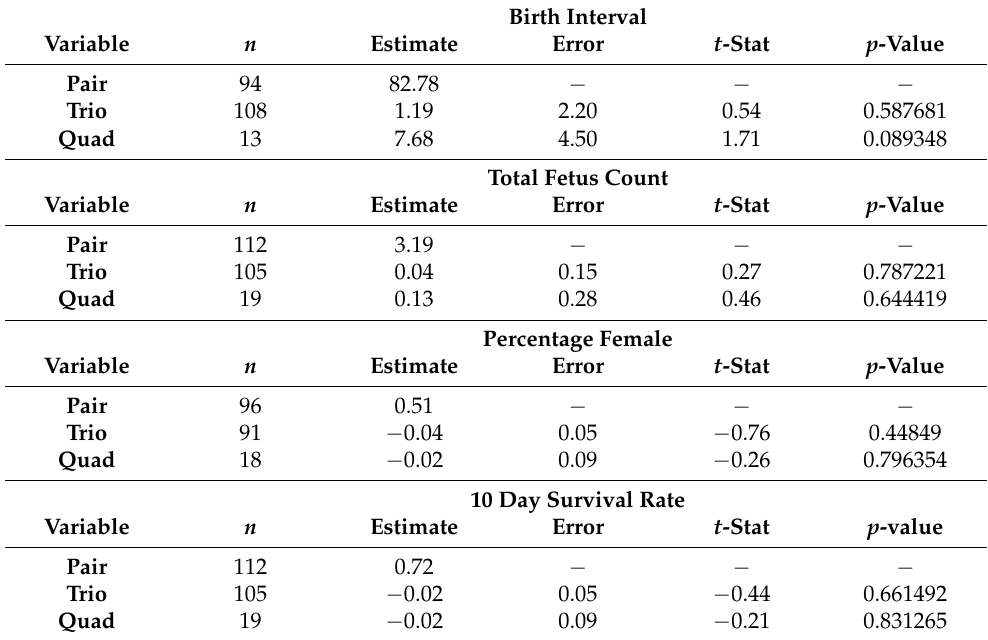
Table 8. Analysis of the effect of strain 13/N guinea pig pairing approaches on breeding outcomes. Trio (one male, two females) and quad (one male, three females) pairing approaches were compared to pairs (one male, one